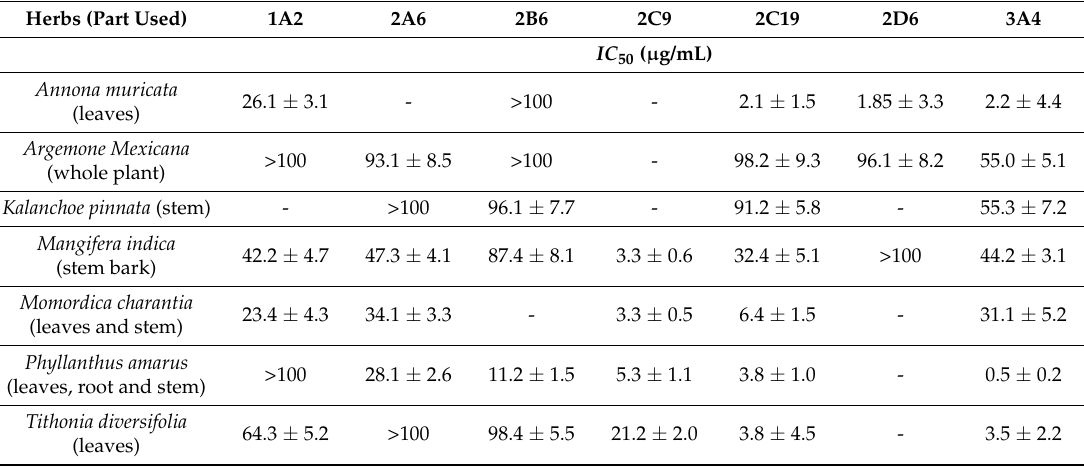
Table 1. The inhibitory potency of the selected antimalarial herbs on the activity of CYP enzymes. Herbs (Part Used)